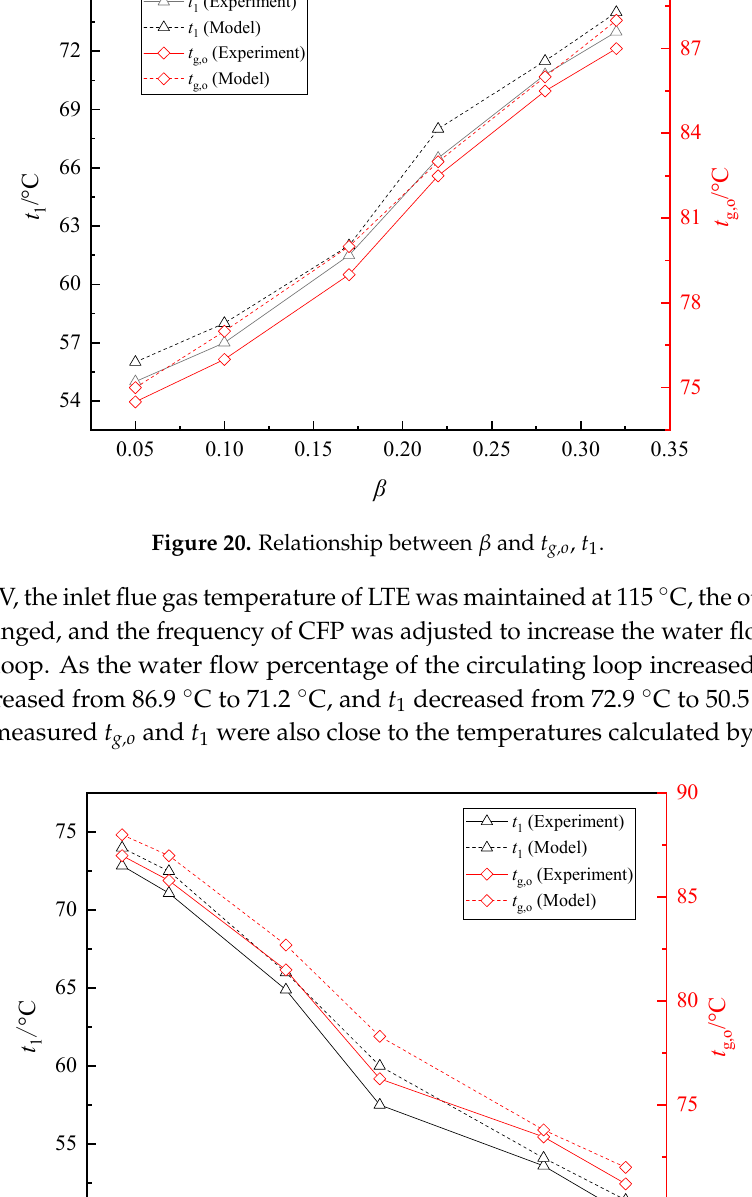
Figure 21. Relationship between circulating flow and t g,o , t 1